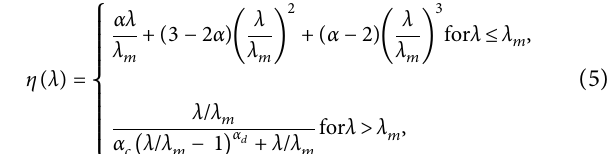
Figure 20: Mortar failure criterion for tie-break contact (unit: 1 × 10 6 Pa).